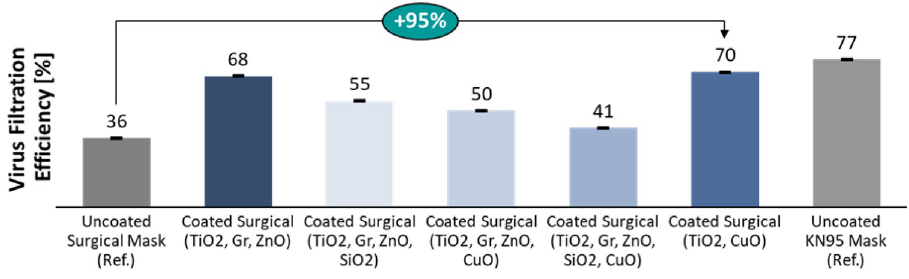
Fig 9. 95% improvement in VFE with nanoparticles as compared to an uncoated mask. The small error bars (at 1 σ ) indicates measurement